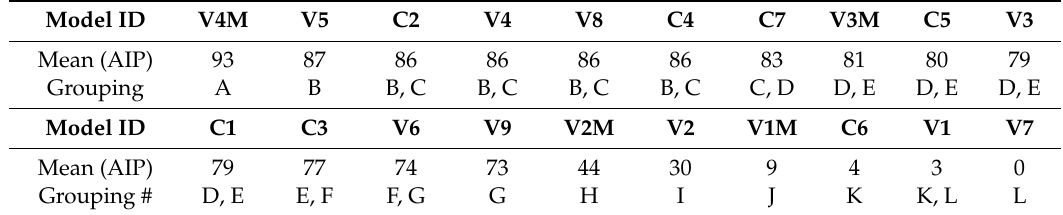
Table 6. Mean difference of the post hoc test for the average mean of AIP (%) of the AGC